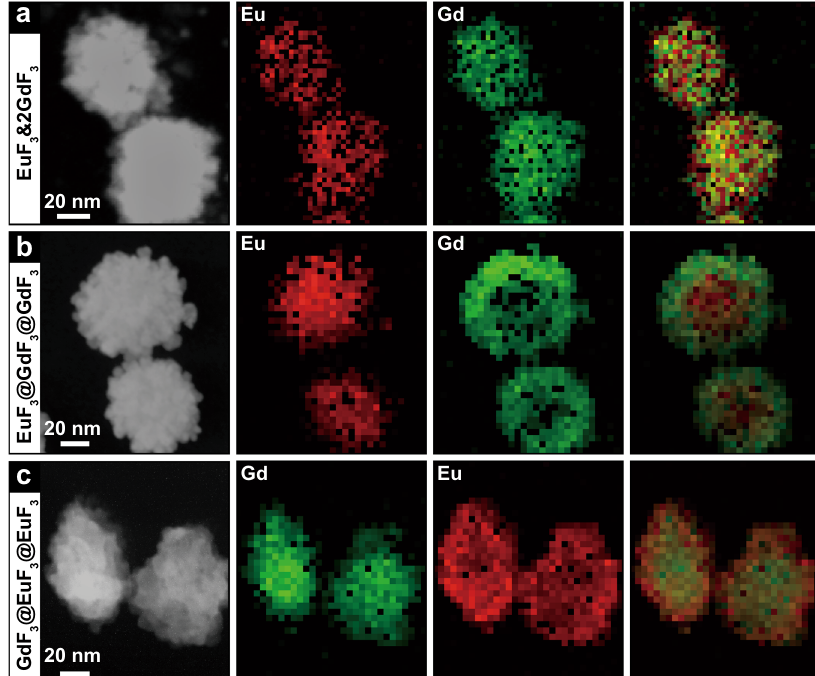
Fig. 6 Structural details of different NCs. High-angle annular dark- fi eld scanning TEM images and corresponding energy-dispersive X-ray elemental mapping results of a EuF 3 &2GdF 3 dimeric, b EuF 3 @GdF 3 @GdF 3 core-shelled, and c GdF 3 @EuF 3 @EuF 3 reversely core-shelled